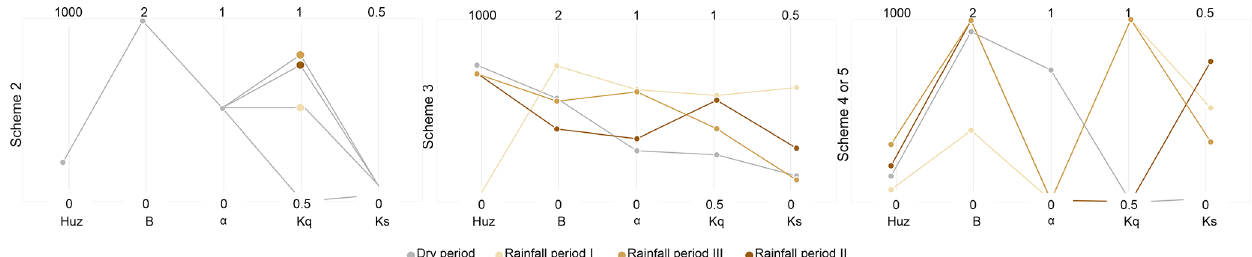
Figure 6. Results of the dynamic-parameter-set assessment. The dynamic parameter sets optimized by the four sub-period calibration schemes in the Hanzhong